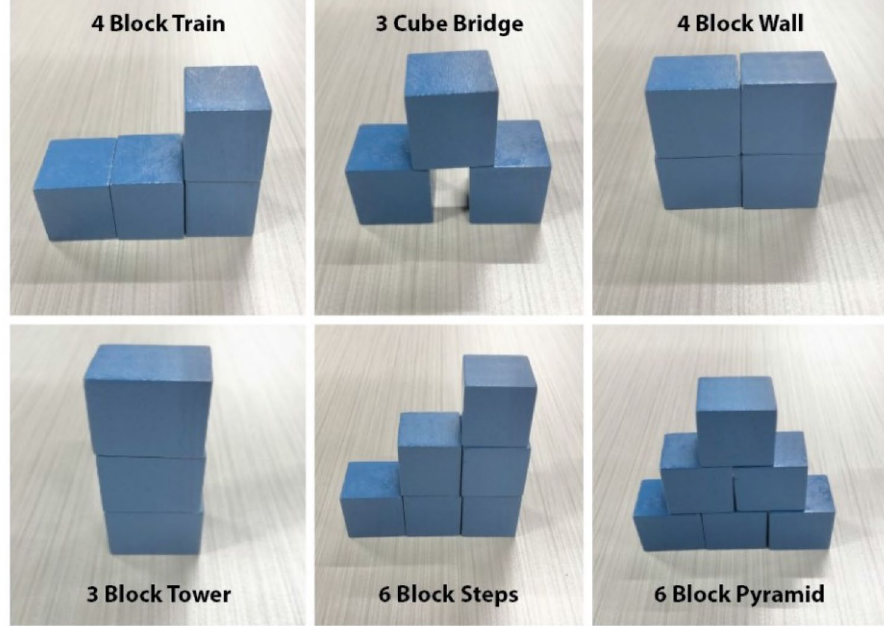
Figure 5. The Block Building activity in which the participant was asked to build a 4 block train (top), 3 cube bridge (middle left), 4 block wall (middle right), 3 cube tower (bottom left), 6 block steps (bottom middle), and 6 block pyramid (bottom right) at both the first and last week of the home intervention